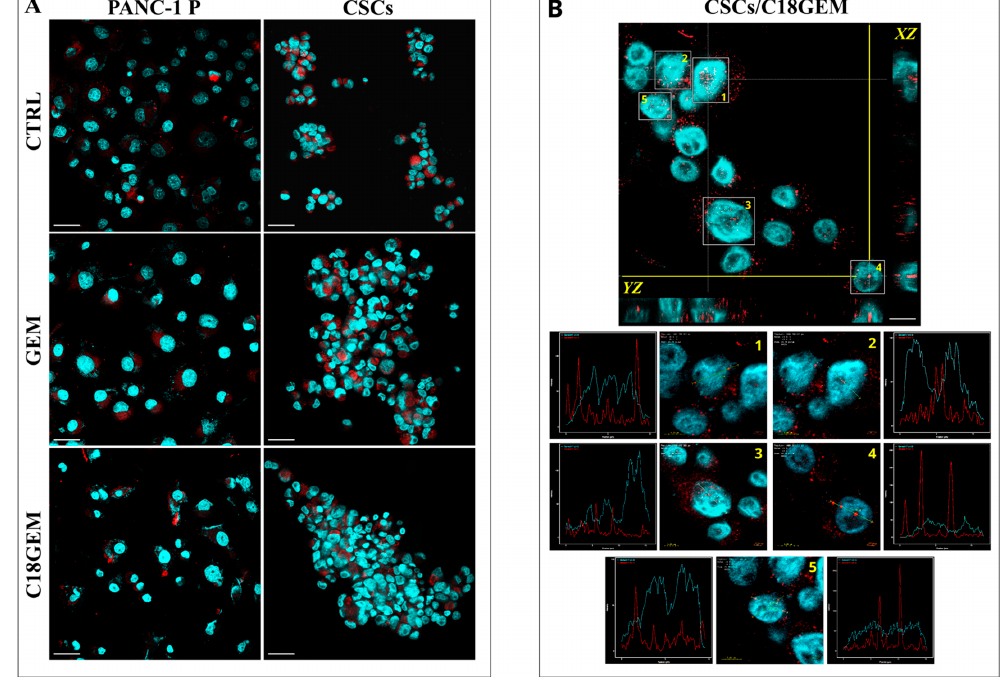
Figure 5. AIF subcellular co-localization. Representative cell images of AIF localization in Panc1 P cells and CSCs treated with 50 μ M of GEM or C18GEM for 48 h acquired by a confocal laser-scan- ning microscope. MIP (maximum intensity projection) images from each analyzed cell line. AIF proteins are red spots and nuclei are in blue. Scale bar, 40 μ m ( A ). Representation of CSCs after treatment with C18GEM. In the upper image, the orthogonal sections (ZX and ZY) show AIF pro- tein (red signal) inside the nuclei (blue signal). The nuclei marked with 1, 2, 3, 4, and 5 are shown at higher magnification. For each nucleus, a yellow arrow has been positioned on a red signal. The corresponding plots show the signal intensity (Y axes) and the position identified by the yellow arrow (X-axes). Scale bar, 20 μ m and 5 μ m ( B ).